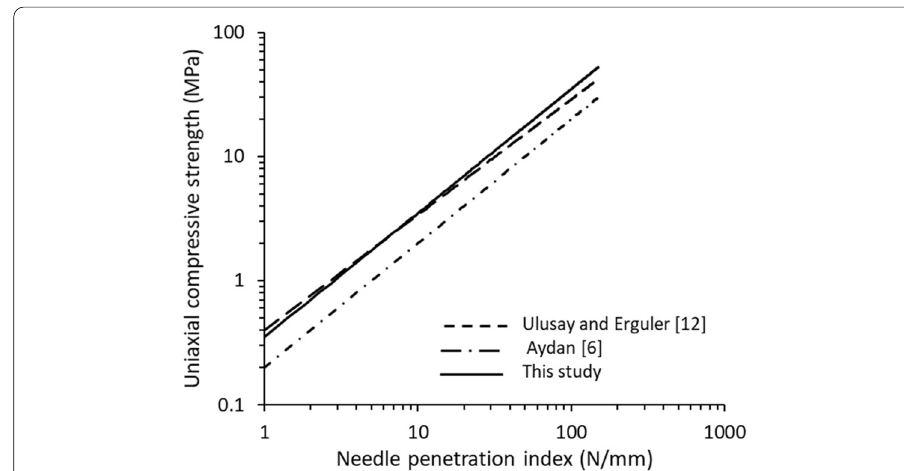
Fig. 6 Comparison between Eq. (17) and literature